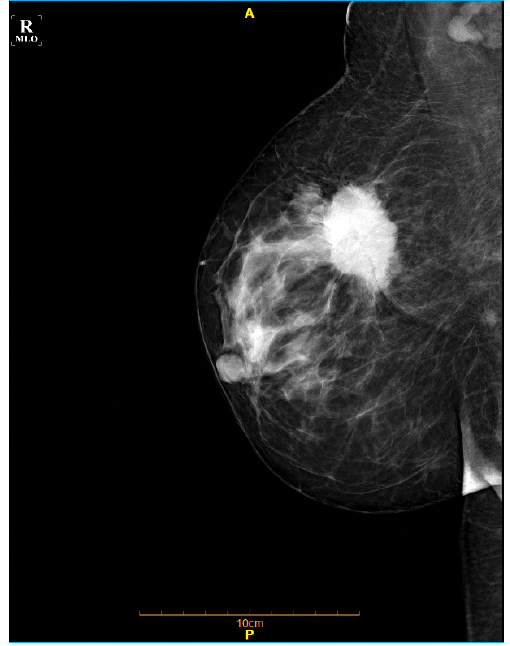
Figure 1. Breast mammography. An irregular speculated hyperdensity mass in the right breast upper outer quadrant.